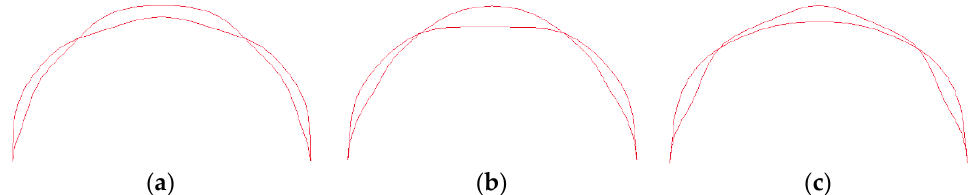
Figure 9. The displacement mode when t = 0.26 s, t = 0.76 s, t = 1.26 s, P11. ( a ) t = 0.26 s, ( b ) t = 0.76 s, and ( c ) t = 1.26 s.